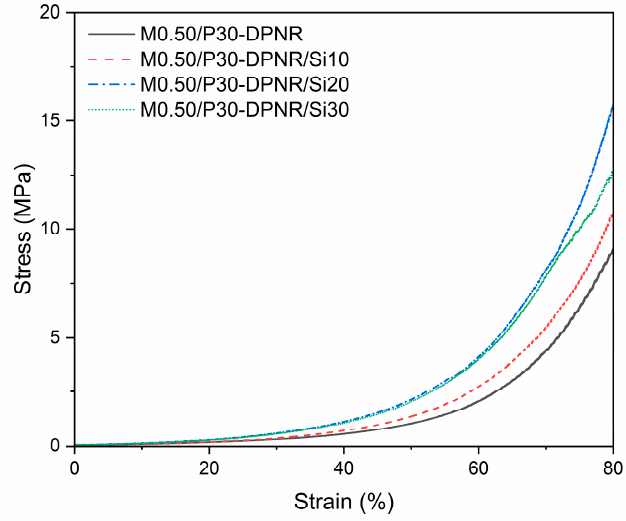
Figure 10. Stress–strain curve of the M0.50/P30-DPNR, M0.50/P30-DPNR/Si10, M0.50/P30- DPNR/Si20 and M0.50/P30-DPNR/Si30 composites. Table 3. Compressive properties of M0.50/P30-DPNR/silica composites with various silica contents.